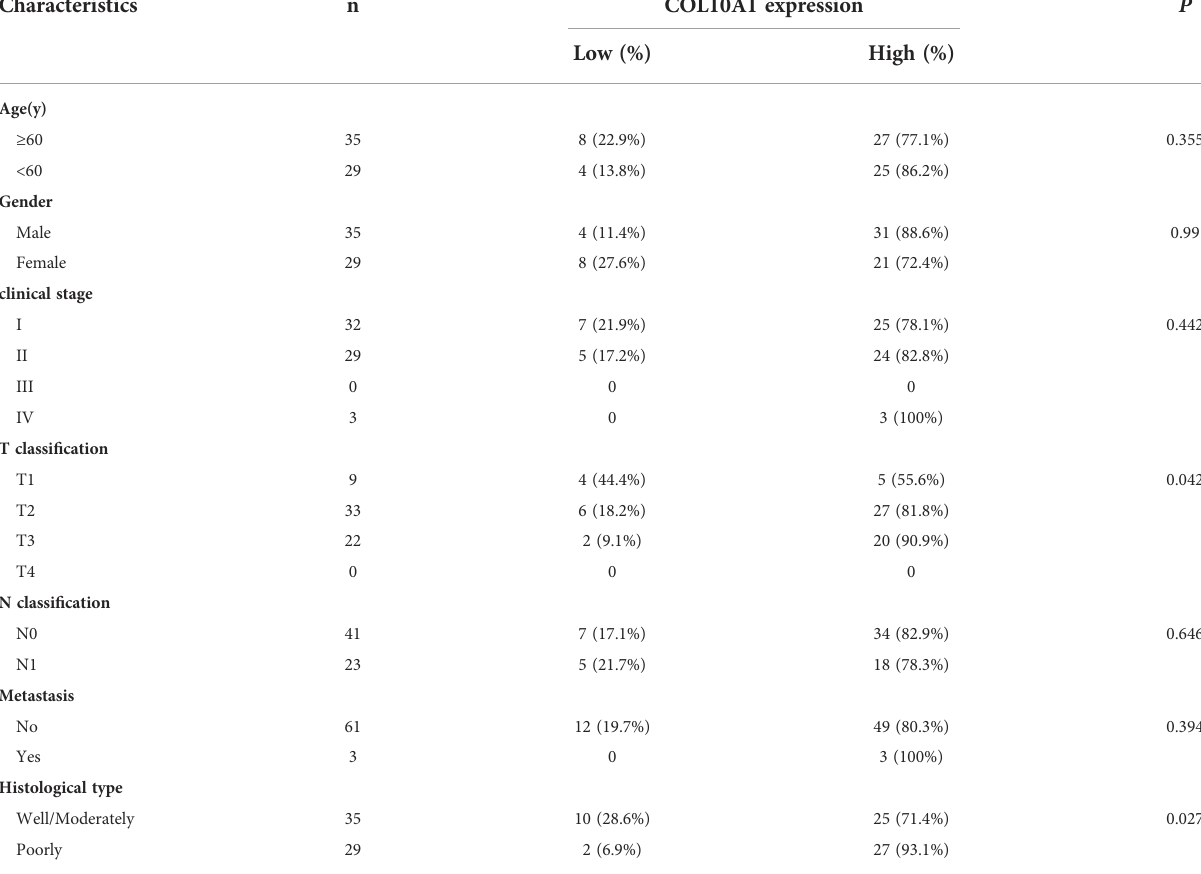
TABLE 1 Clinical characteristics of PDAC patients with low COL10A1 expression and high COL10A1 expression.